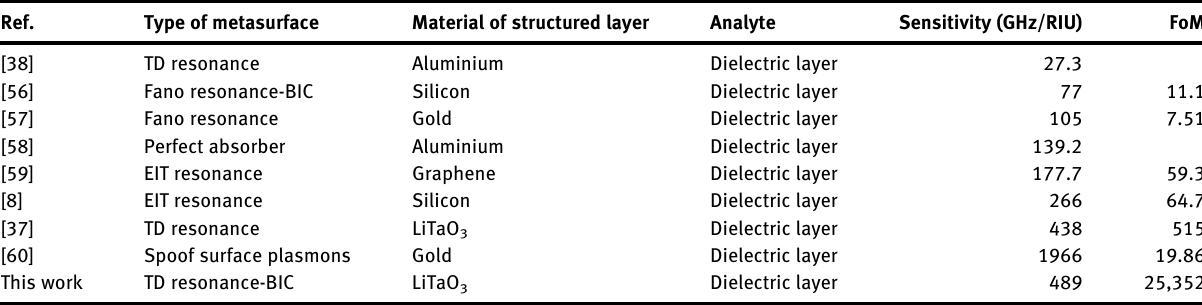
EIT, electromagnetically induced